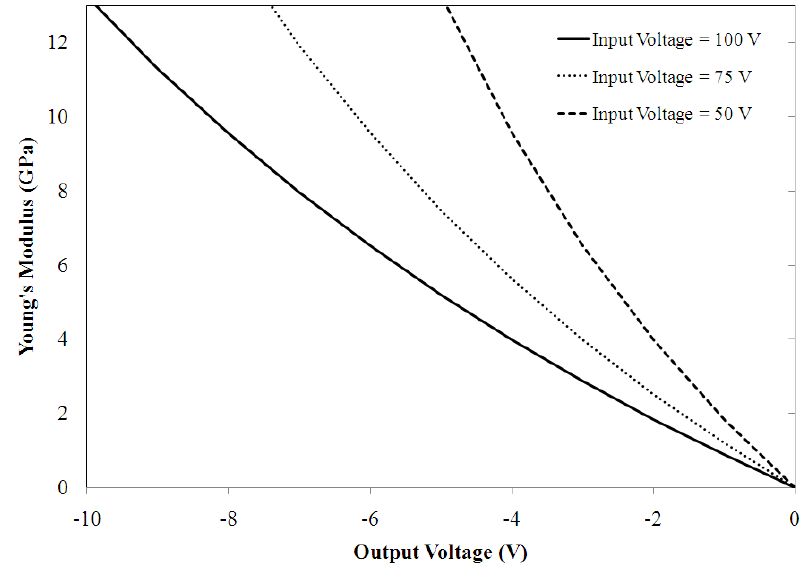
Figure 11. Predicted test material’s elastic modulus relative to the induced voltage and applied voltage.